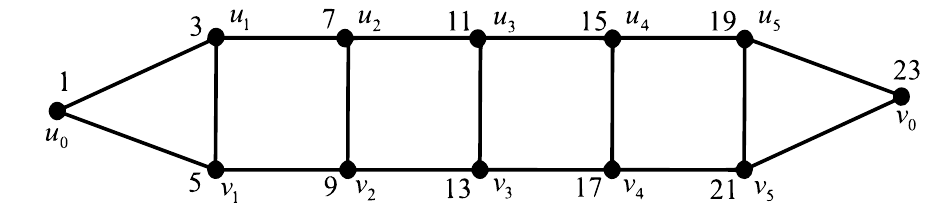
Figure 4: Arrow graph D A 2